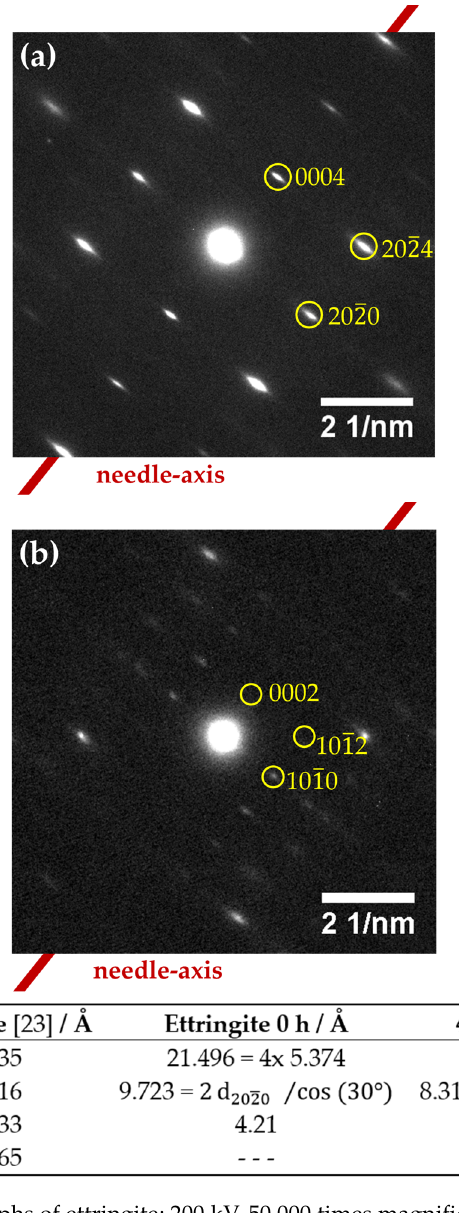
Figure 7. SAED micrographs of ettringite; 200 kV, 50,000 times magnification; ( a ) 550 nm selected circular area on pristine ettringite; ( b ) 250 nm selected circular area on dehydrated ettringite after a treatment of 48 h at 60 µ bar; [1010] zone axis; Bravais–Miller indices of both patterns are indexed according to a hexagonal unit cell; and ( c ) cell parameters derived from TEM-based SAED of pristine ettringite and ettringite treated at 60 µ bar for 48 h compared to data by Hartman et al. [23].